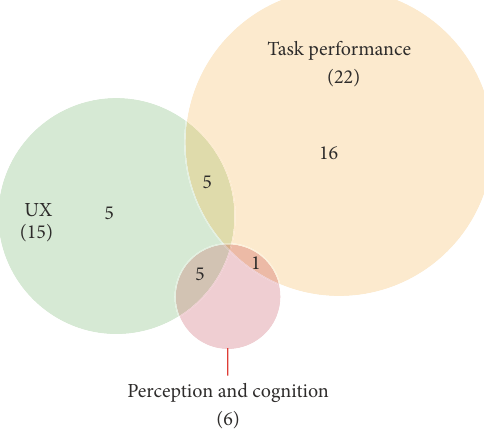
Figure 2: Type of evaluation in articles numbers.